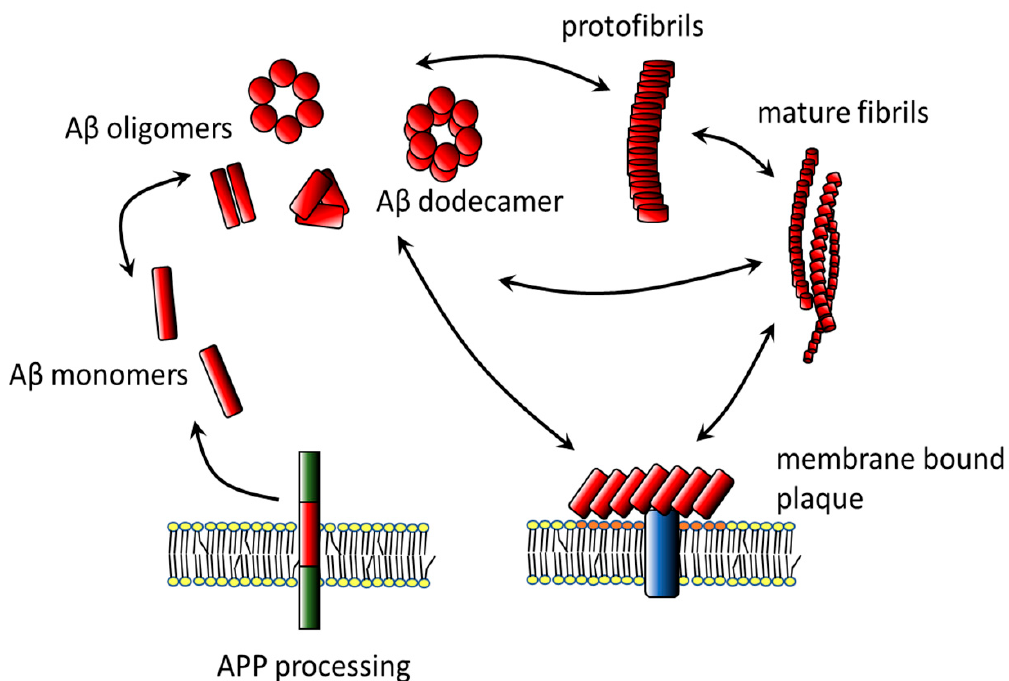
Figure 1. Amyloid β oligomerization. After processing of amyloid precursor protein (APP) by secretase enzymes, A β monomers are released into the intercellular space. In dependence on the environment, A β form and concentration, monomers may aggregate into supramolecular structures including low and high-molecular clusters. Among them, the 56 kDa A β dodecamers show the highest extent of neurotoxicity. Amyloid oligomers may form either globular, or fibrillar conglomerations known as protofibrils and fibrils. Membrane bound fibrils organize into amyloid plaques. A β clustering and fragmentation are reversible processes, so mutual interconversions between particular forms occur.